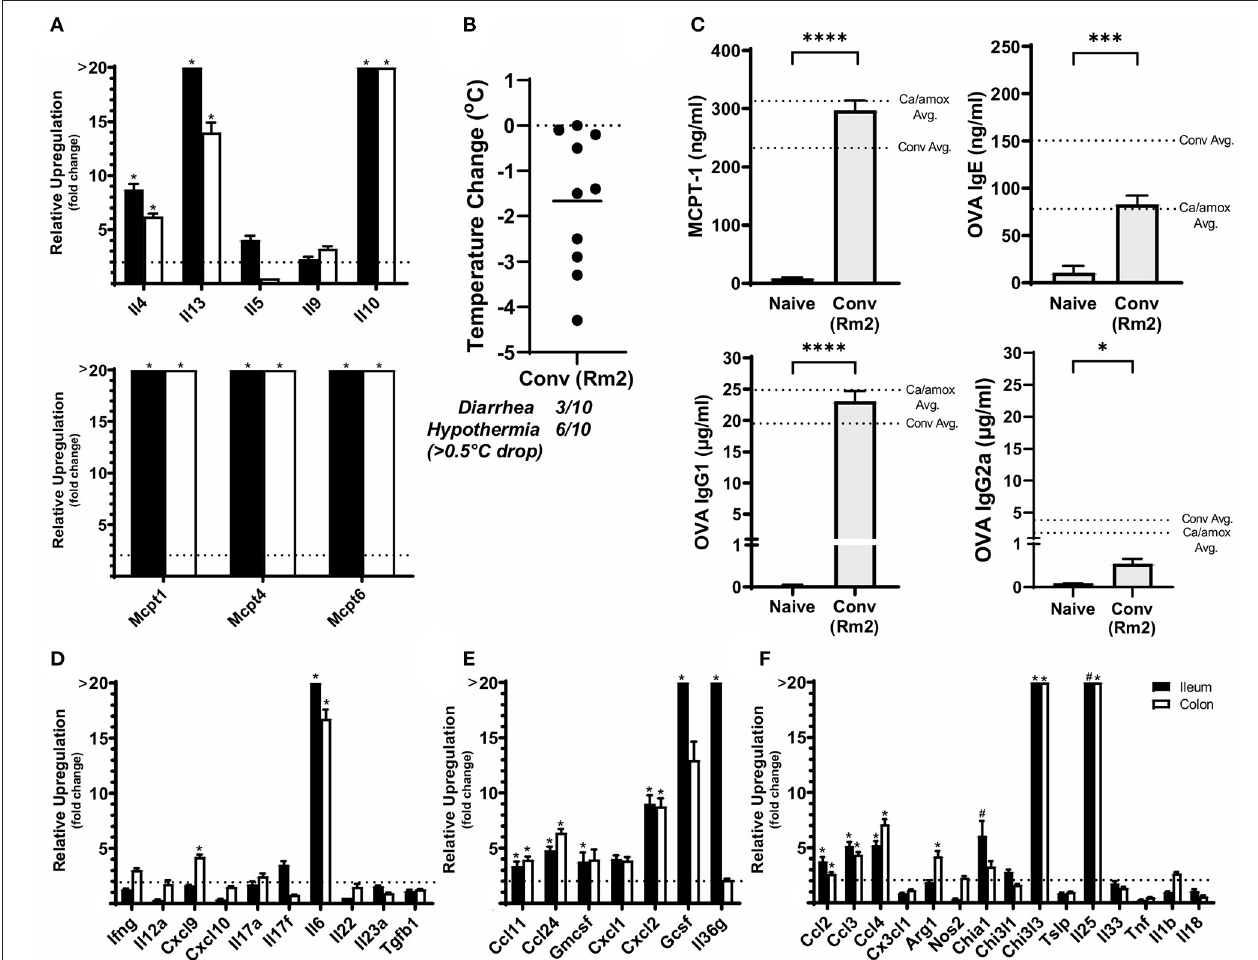
FIGURE 6 | Anaphylaxis measurements and relative cytokine gene expression after the final challenge in food allergic Balb/cJ mice tested for environmental impact on the microbiome (Conv Rm2). (A,D–F) Relative expression of cytokine genes in the ileum and colon of Conv (Rm2) mice post final challenge. (B) Average body temperature drop from 15 to 90min in sensitized/challenged mice, total number of mice with an incidence of diarrhea, and number of mice with hypothermia defined as > 0.5 ◦ C drop per group. Body temperature was recorded after the final oral challenge via rectal probe. (C) Average serum levels of MCPT-1, OVA-specific IgE, IgG1 and IgG2a for Conv (Rm2) mice compared with averages of Conv and Ca/amox groups ( Figure 3 ). Mice were treated as outlined in Figure 1A starting at D13. Gene expression was measured by qPCR and is shown as relative expression compared to naïve strain-matched mice. The dotted line indicates a two-fold upregulation from baseline expression levels. Statistical significance (* P < 0.05) signifies significant upregulation in the treated compared to the naïve group for each gene (treated, n = 10, naïve, n = 5). A bar notated with a # indicates an average upregulation > 5 across the group, but P > 0.05 due to high variance in the overall dataset. Data are plotted with the mean ± SEM. Detailed description of analyses and statistical tests used can be found in the Materials and Methods. Statistical significance is * P < 0.05, *** P < 0.001, and **** P < 0.0001. Definitions of gene abbreviations can be found in Table 1